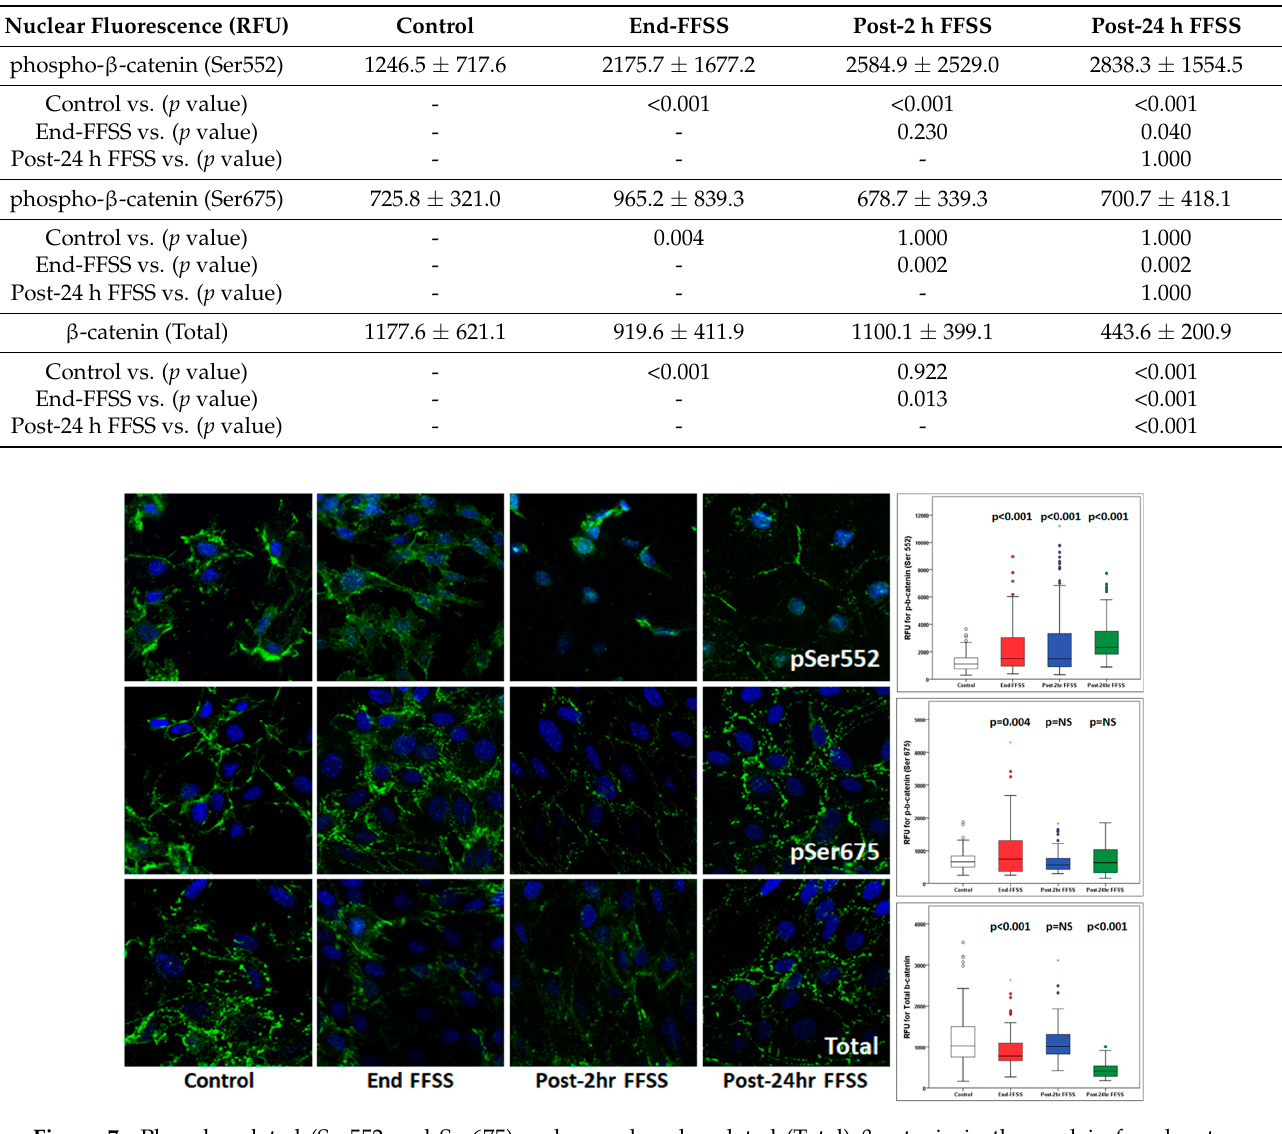
Table 4. Levels of phosphorylated and non-phosphorylated (Total) transcription factor β -catenin in the nuclei of podocytes exposed to fluid flow shear stress (FFSS) using immunofluorescence microscopy. The fluorescence from untreated (Control) cells was compared with podocytes exposed to FFSS at 2 dynes/cm 2 for 2 h at the end of FFSS, (End-FFSS), Post-2 h FFSS, and Post-24 h FFSS. The relative fluorescence units (RFU) values are shown as the Mean ± SD; the p-values were obtained using Univariate Analysis of Variance with pairwise comparison, corrected using the Bonferroni post-hoc test.